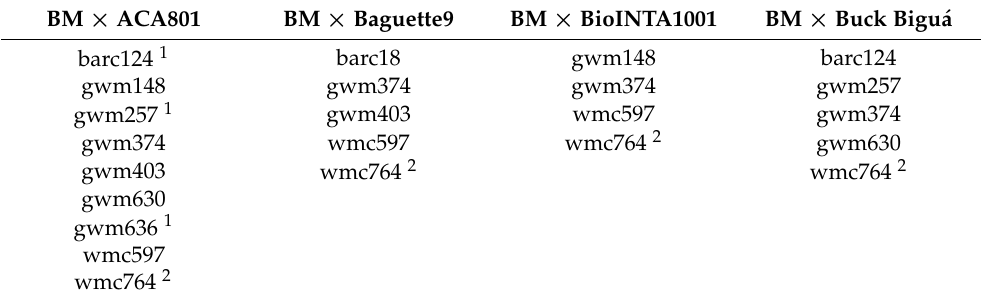
Table 2. SSRs used for Buck Manantial chromosome 2BS selection. 1 used only in BC1 2 linked to Lr16 (Figure 2).